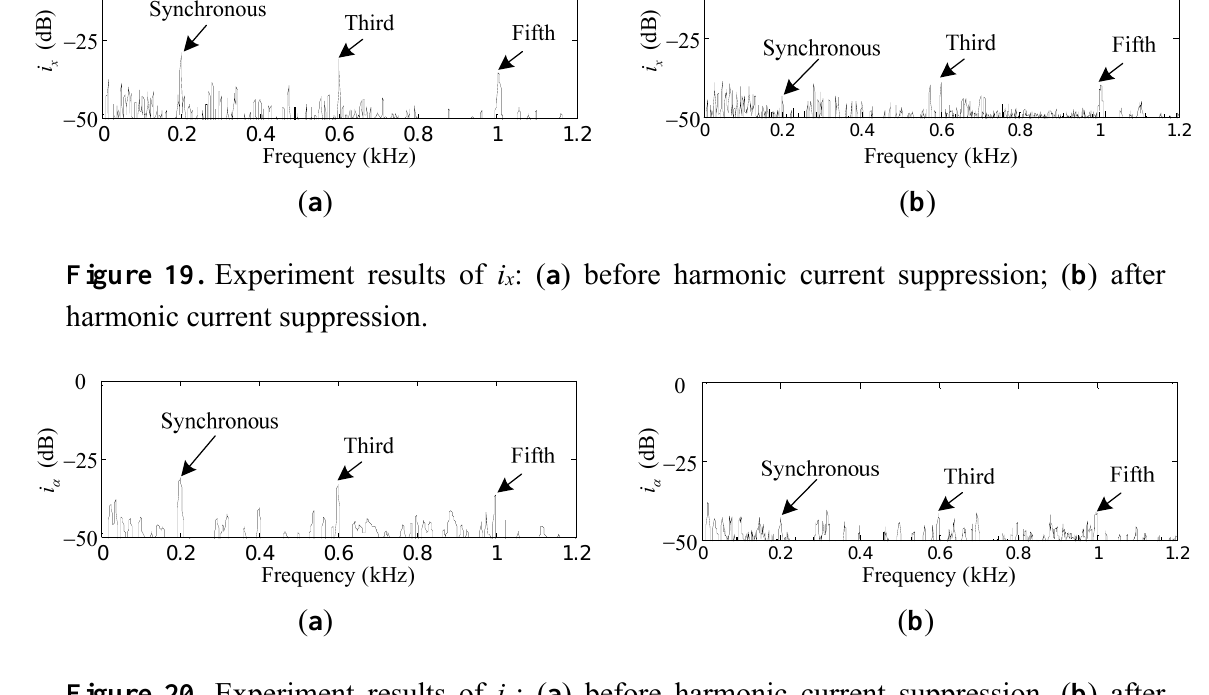
Figure 20. Experiment results of i α : ( a ) before harmonic current suppression. ( b ) after harmonic current suppression.